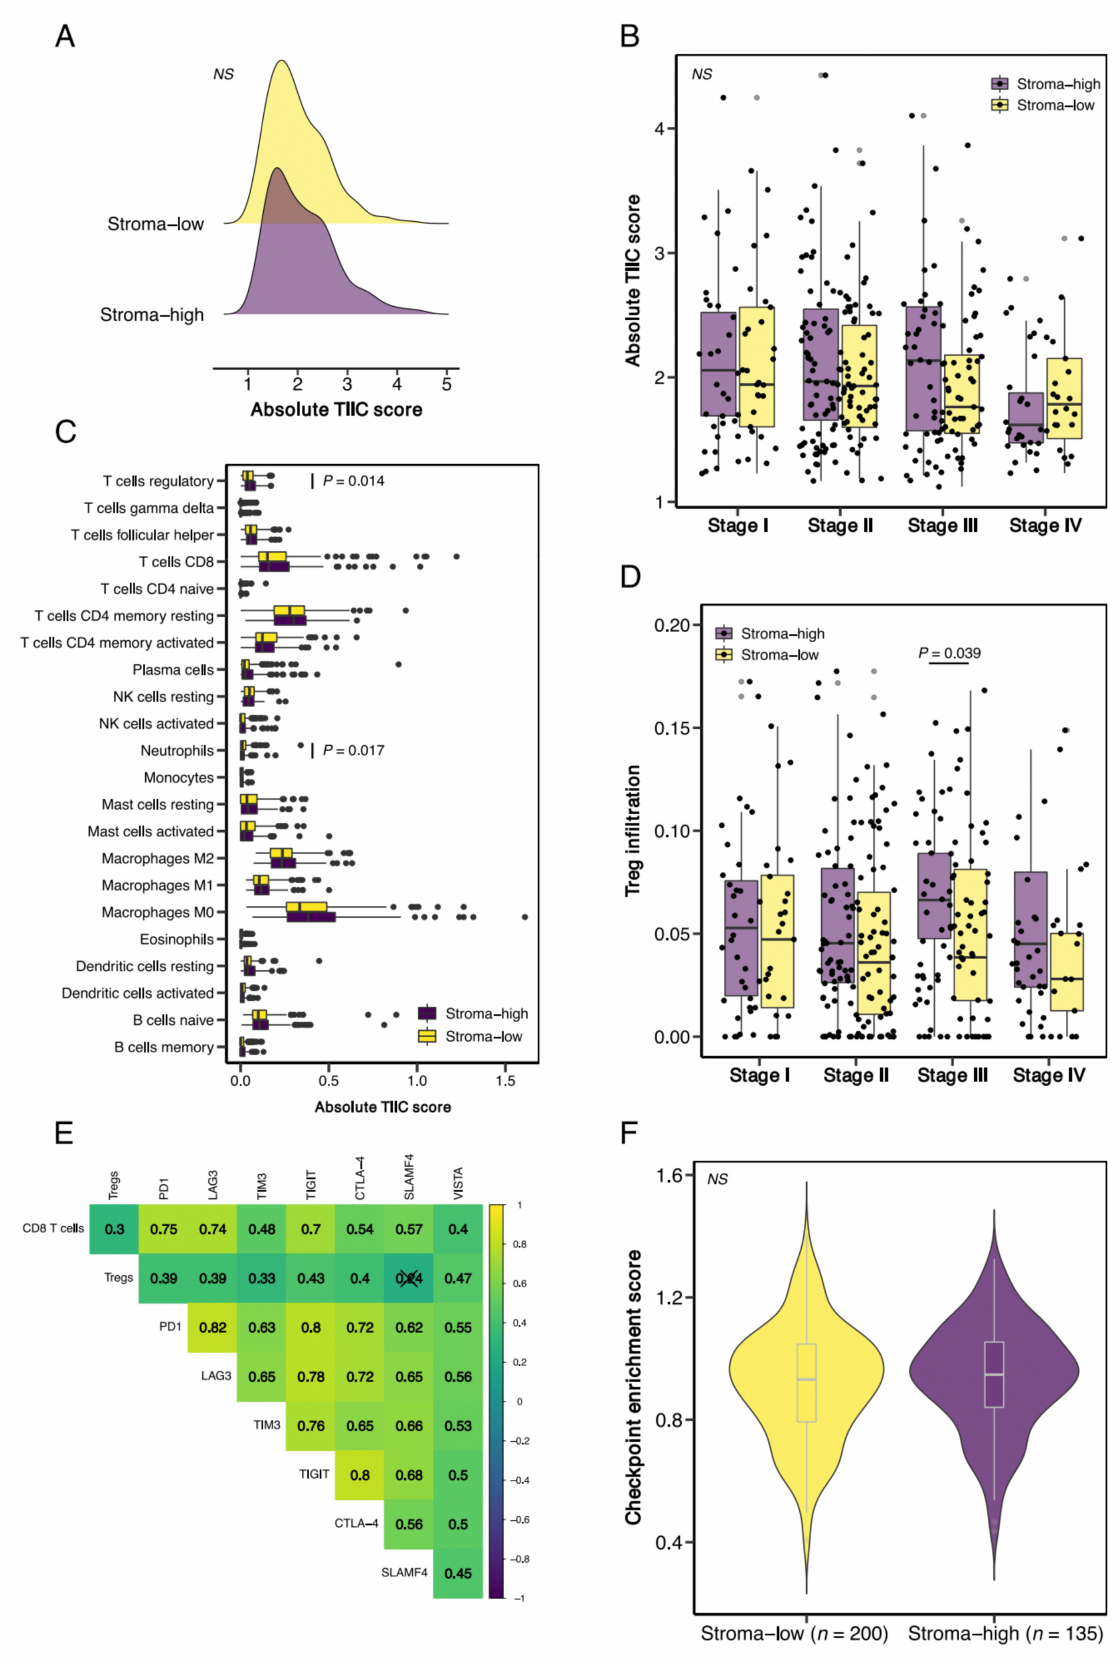
Figure 3. The tumor–stroma ratio (TSR), T regulatory cells (Tregs), and T cell exhaustion markers. ( A ) Total TIIC